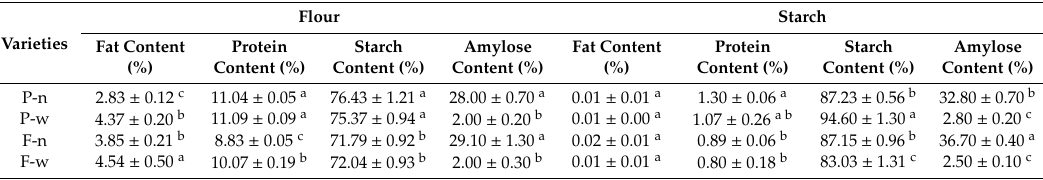
Table 1. Chemical compositions of flours and